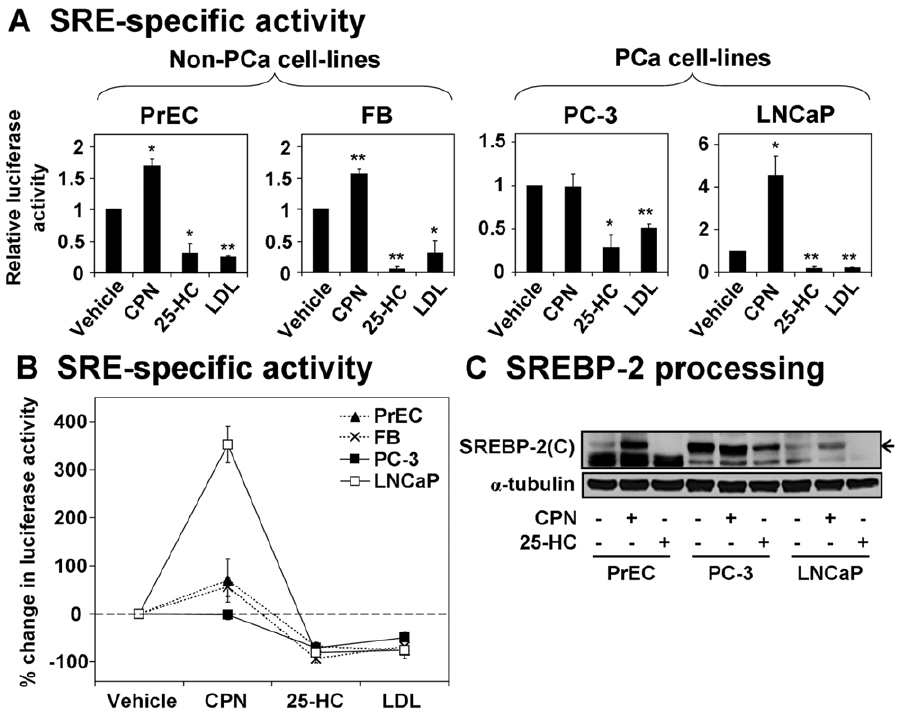
Figure 2. Responses to changing sterol status involve SREBP-2 activation in prostate cancer cells. (A) Cells were transfected as described in Materials and Methods. Treatment included the statin compactin (CPN, 5 m M), oxysterol 25-HC (1 m g/ml), or LDL (50 m g/ml) for 24 h. SRE-specific luciferase activity was determined as described in Materials and Methods, and normalized to the vehicle condition. The wildtype and mutant promoter values are shown in Fig. S1. Data are mean + SEM, from 3 separate experiments for each cell-line. Each experiment was performed with triplicate wells per condition. * p , 0.05, ** p , 0.01, two-sample t -test versus vehicle condition. (B) Data from (A) has been overlaid, represented as mean 6 SEM for each datapoint. The PCa cell-lines are represented by solid lines, whilst the non-PCa cell-lines are represented by broken lines. (C) Cells were treated with CPN (5 m M) or 25-HC (1 m g/ml) for 24 h. Cell lysates were subjected to SDS-PAGE and Western blotted with the IgG-1C6 anti-SREBP- 2 antibody. The C-terminal cleavage product of SREBP-2, SREBP-2(C), is labeled with an arrow – we assume that the band below is a non-specific band. Probing for a -tubulin served as an internal loading control. The blot shown is representative of at least 2 separate experiments for each